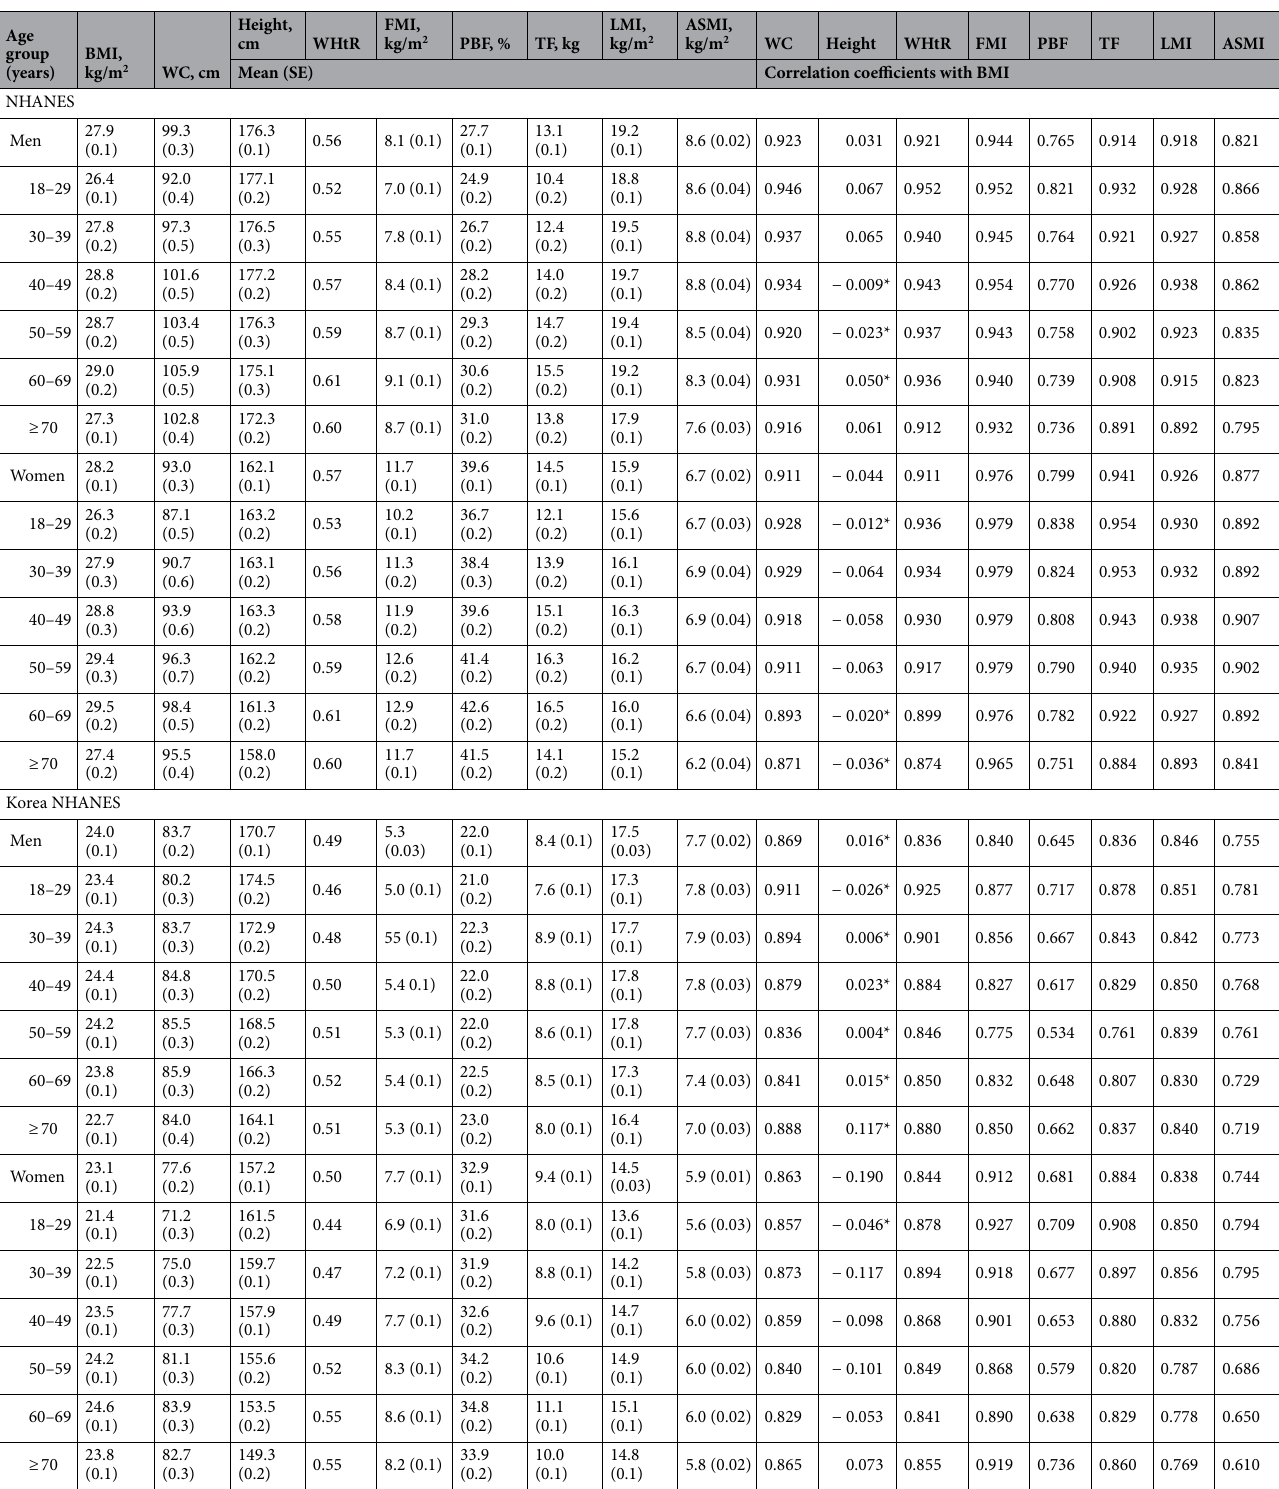
Table 1. Pearson correlation of waist circumference, percentage body fat, lean body mass index and fat mass index with body mass index by sex and age group in National Health and Nutrition Examination